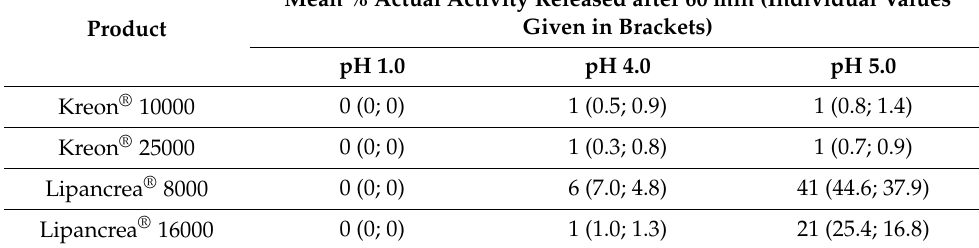
Table 4. Comparison of percentage of actual activity released after 60 min at pH 1.0, 4.0 and